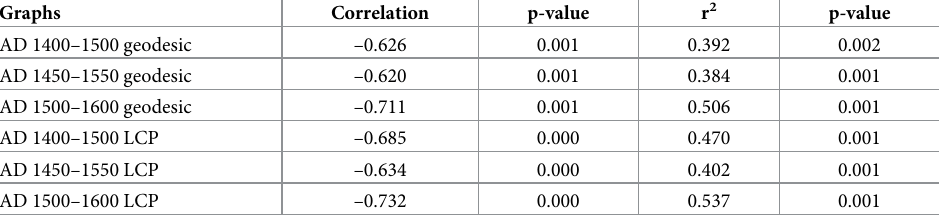
Table 2. QAP correlation and regression results of geodesic and LCP centroid distances on average BR similarity values between geographic